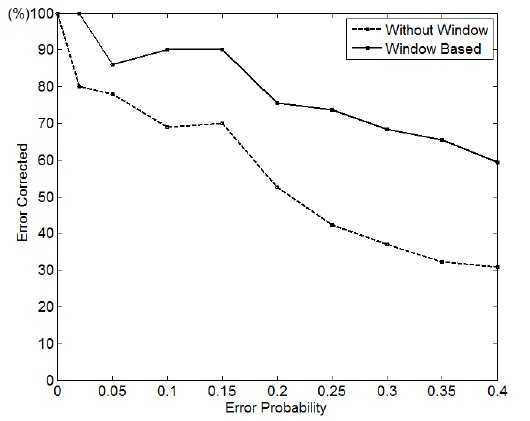
Figure 6. Comparison of Proposed Method and The Method in [9] On Probability of Errors Introduced.